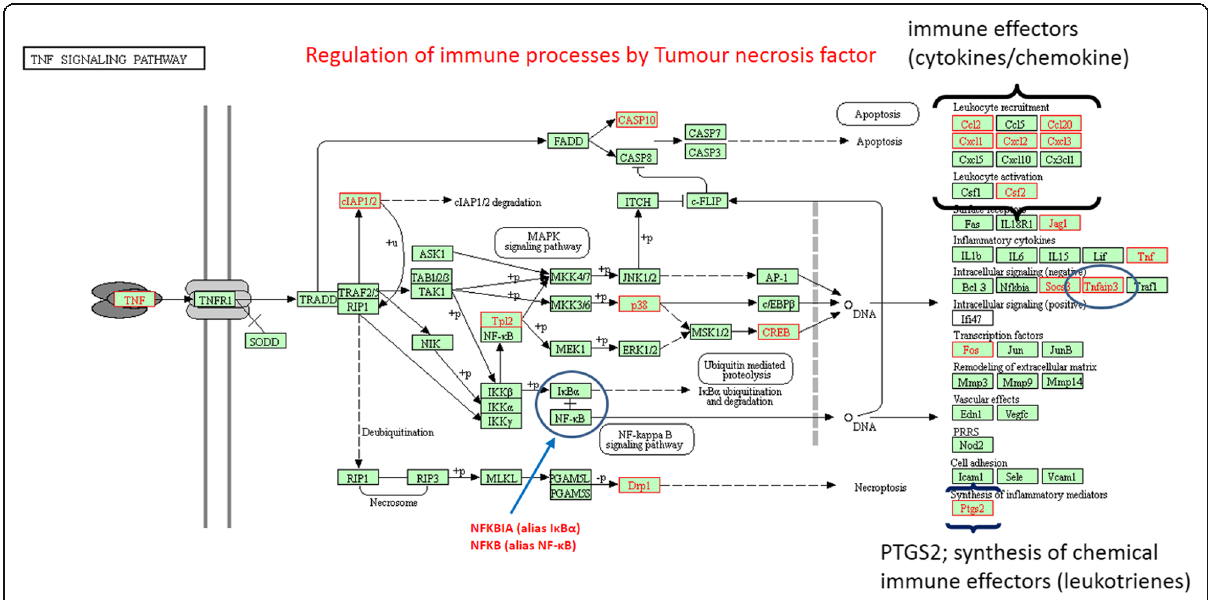
Fig. 2 Regulation of immune EP expression by Tumour necrosis factor (TNF) signalling after exposure of IPEC-J2 cells to micro algae extracts in the absence and presence of ETEC. DEGs are highlighted in red or encircled in the original KEGG “ TNF signalling pathway ”